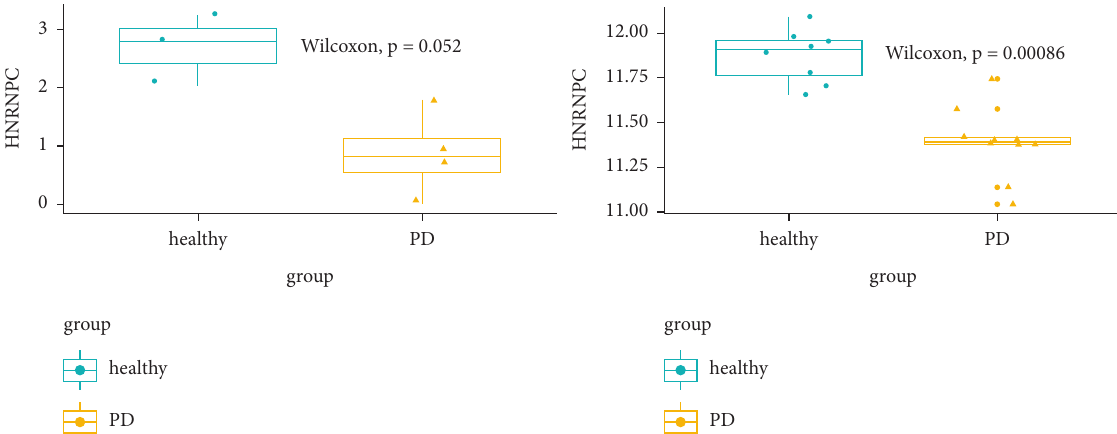
Figure 4: The expression of HNRNPC gene in two sets of data